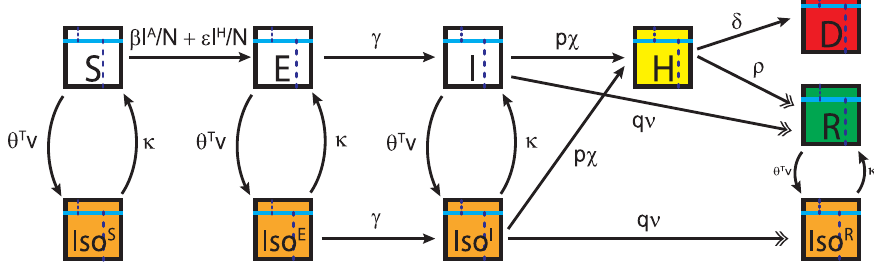
Fig 1. Compartmental model. Each box represents an individual compartment and the arrows represent transitions between the compartments. The individuals in every compartment are divided by age, as represented by the cyan bars, their pre-pandemic productivity, as represented by the dotted lines, and by changes to their pandemic productivity, as represented by the background color of the boxes. White boxes represent normal pre-pandemic productivity, dead individuals have no productivity, which is represented in red, isolated individuals have decreased productivity, which is represented in yellow, and hospitalized individuals have no productivity and incur treatment costs, which are also represented in red. As individuals recover, they receive a small boost in productivity due to their acquired immunity if they are in isolation, which is represented in green.